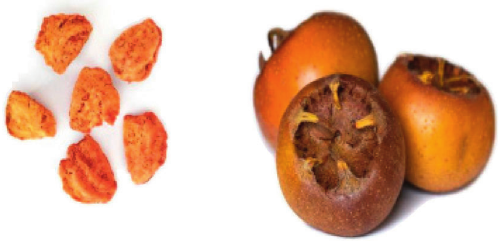
Figure 1: Mespilus germanica and its core.